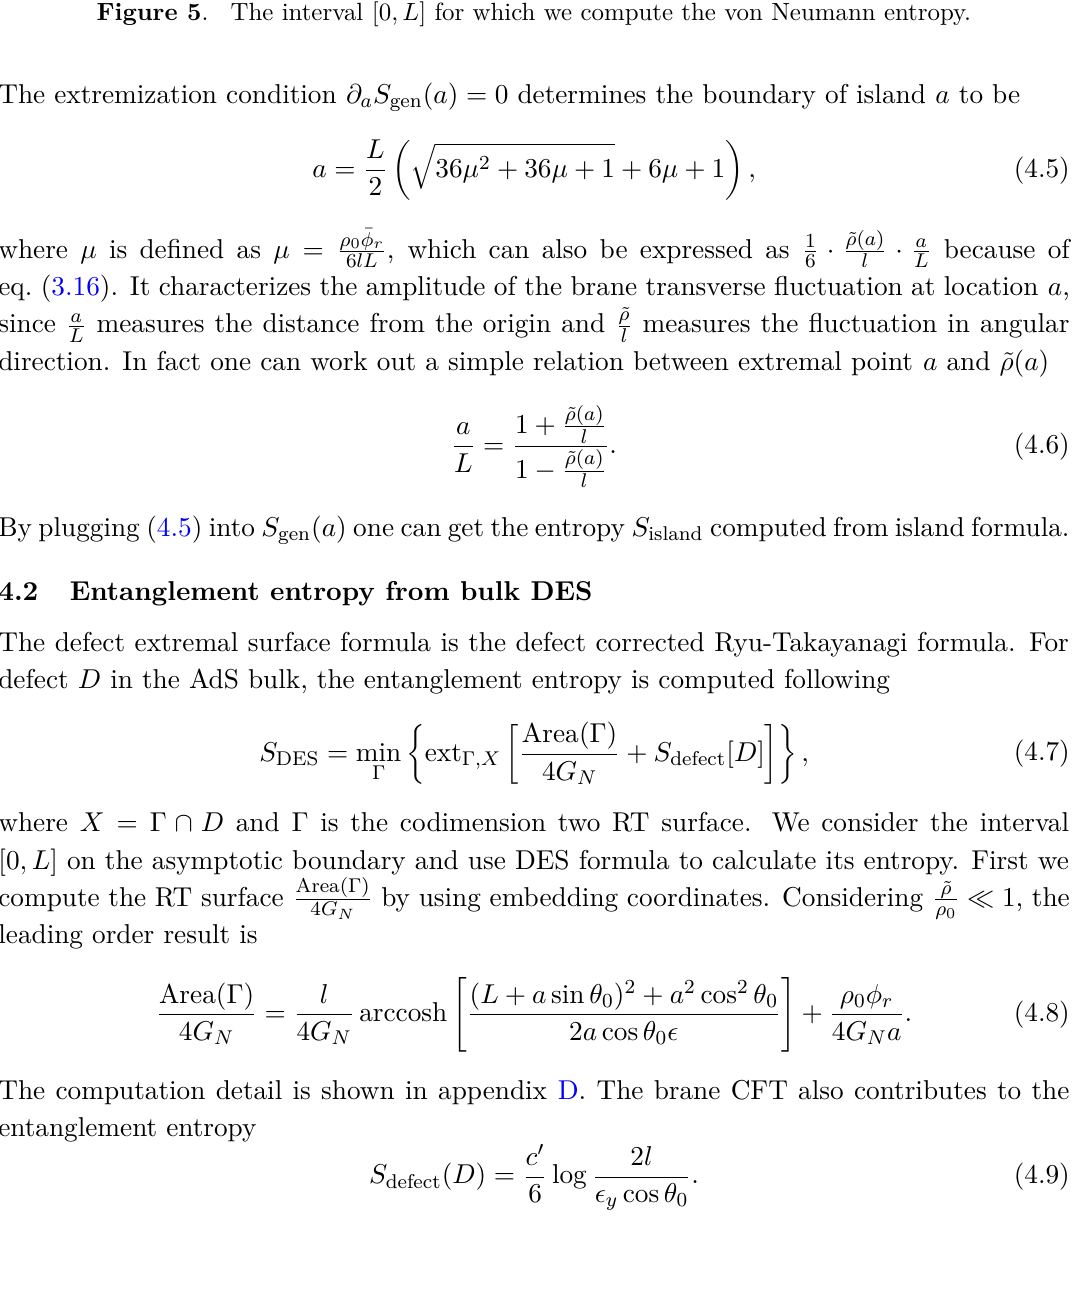
Figure 5 . The interval [0 , L ] for which we compute the von Neumann